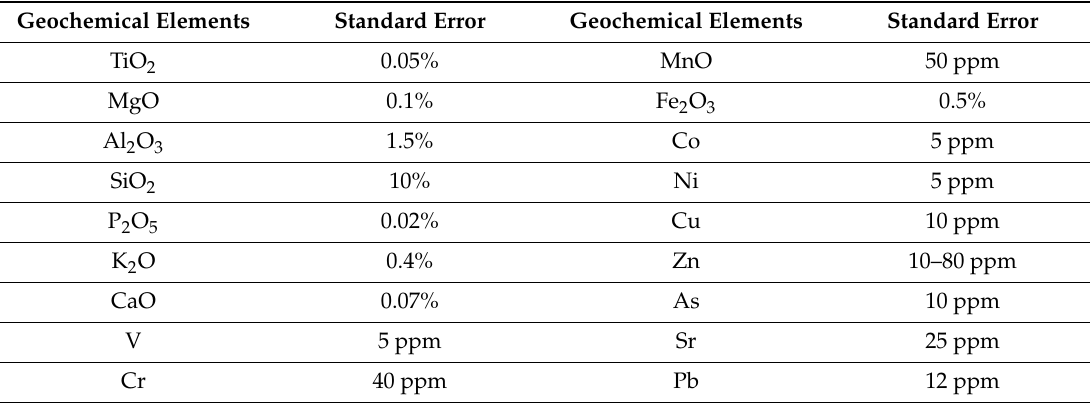
Table 1. The analytical error for geochemical